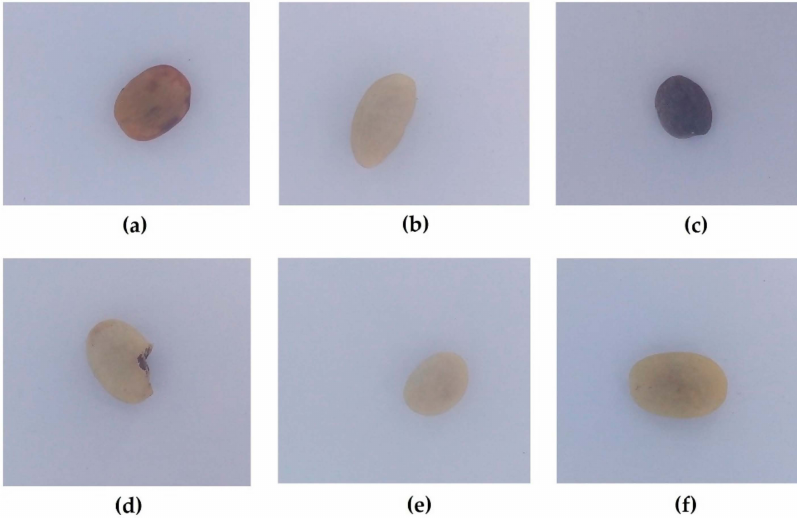
Figure 1. Co ff ee bean types: ( a ) sour defect type, ( b ) very long-berry defect type, ( c ) black defect type, ( d ) broken defect type, ( e ) small defect type, and ( f ) high-quality co ff ee